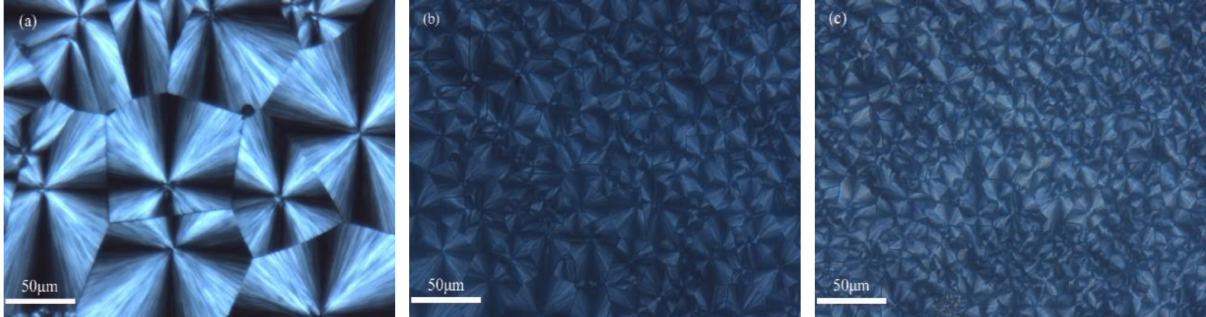
Figure 6. Spherulites of ( a ) neat b-PES, ( b ) b-PES/CA0.1 and ( c ) b-PES/CA0.2 after isothermal melt crystallization at 60 ◦ C.